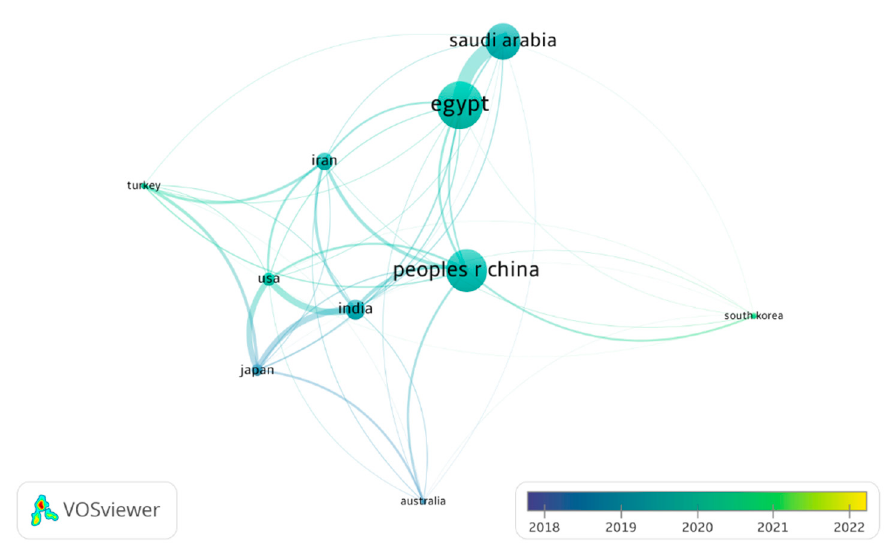
Figure 11. Countries’ collaborative network on PMSG FRT considering the existing publications.